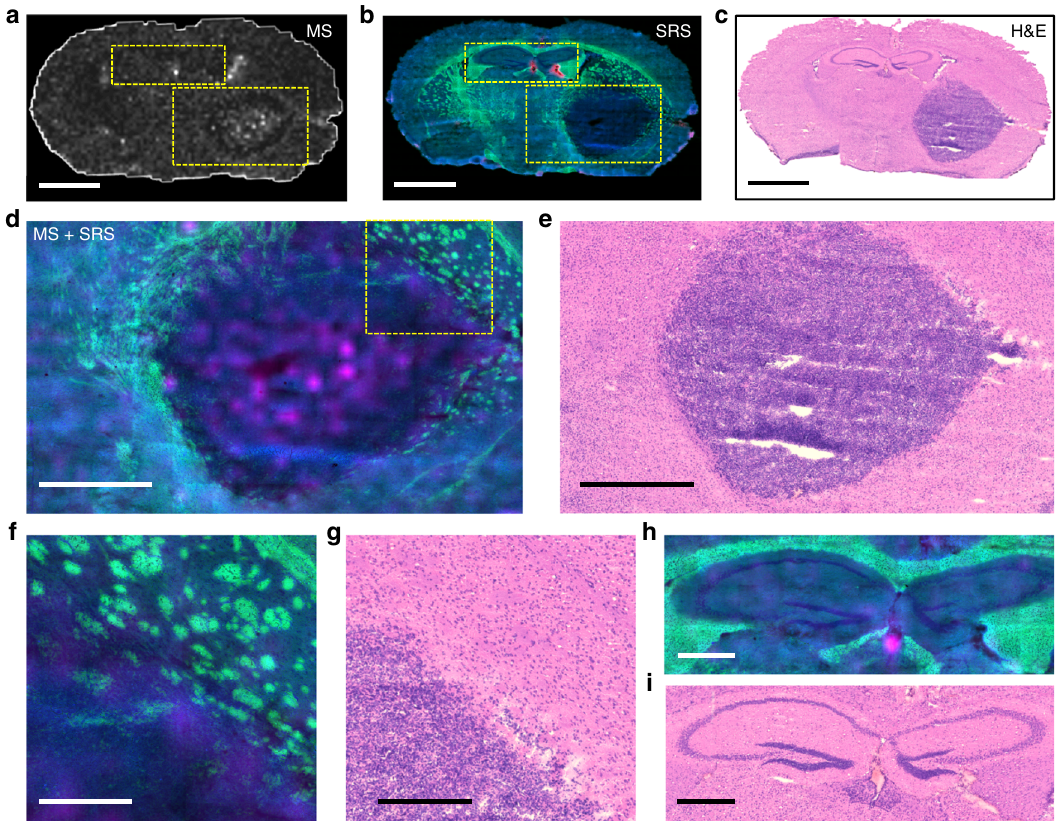
Fig. 3 Correlated MALDI MS imaging of the drug (erlotinib) distribution and SRS imaging of the brain tissue morphology. a MALDI MS ion imaging shows the distribution of Erlotinib across the entire brain tissue section. b SRS imaging shows the chemical constituents (lipid in green; protein in blue; and heme in red) of the entire serial brain tissue section. c H&E image of another serial brain tissue section corresponding to a and b. d Enlarged overlaid view of areas marked by the large rectangle in a and b shows distribution of the drug (erlotinib in pink) and tissue morphology (lipid and protein in green and blue, respectively) of the tumor area, e H&E image corresponding to d . f Enlarged overlaid images of the tumor margin area (marked by rectangle in d ) shows cancer cell invasion into the normal fatty brain structure. g H&E image corresponding to f . h Enlarged overlaid images of the brain structure (marked by smaller rectangle on a and b featuring the difference between gray (protein rich — blue) and white (lipid rich — green) matter. High concentration of erlotinib was found in the third ventricle h , with corresponding H&E image shown in i . Scalebars represent lengths as follows: a – c = 1 mm, d and e = 500 µ m, f – i